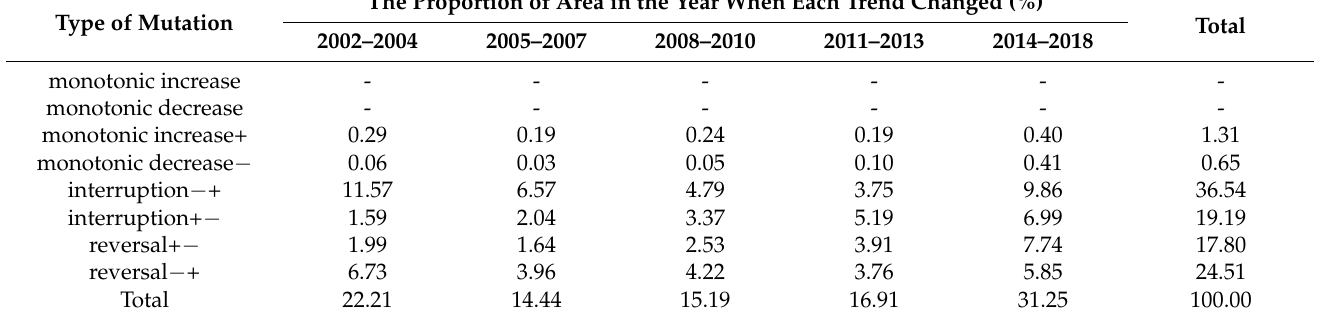
Table 6. Year distribution of changes in each mutation